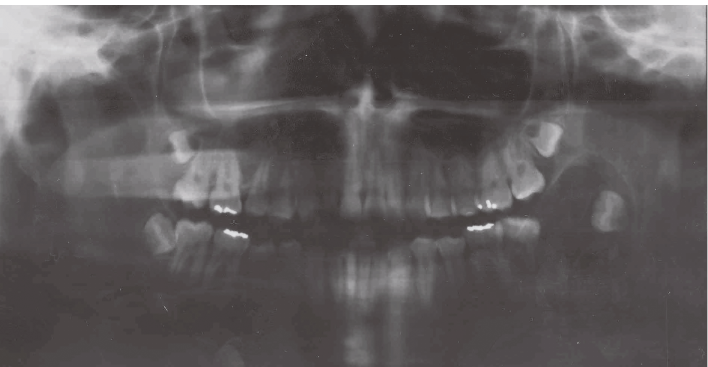
Figure 1: Radiolucent and well-delimited lesion surrounding the third molar in the left side of the mandible.